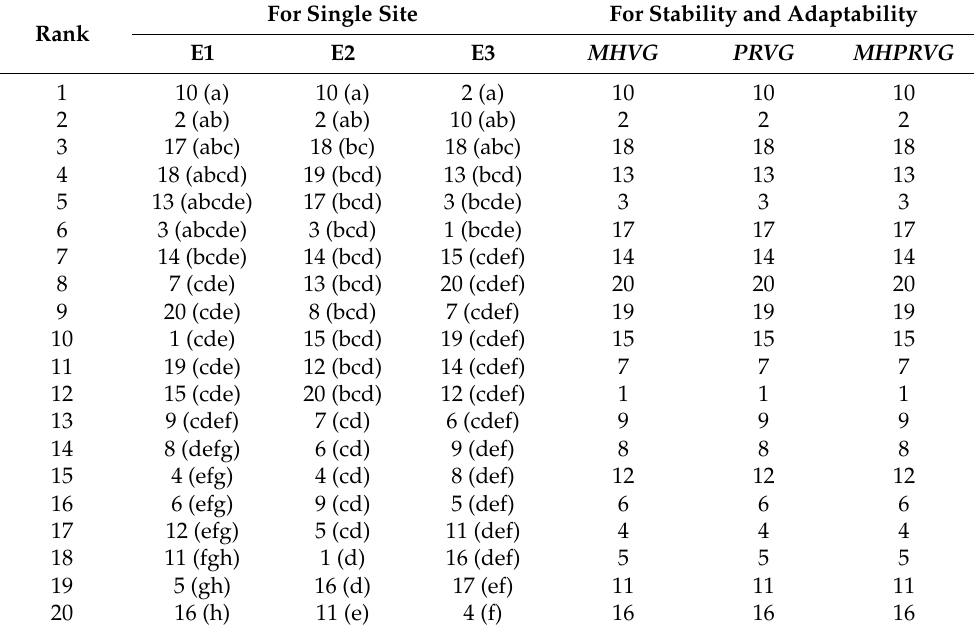
Table 7. Ranking of the 20 clones for each site and selection of the optimal genotypes based on DBH; genotypic stability ( MHVG ); genotypic adaptability ( PRVG ); and productivity, adaptability, and stability ( MHPRVG ).